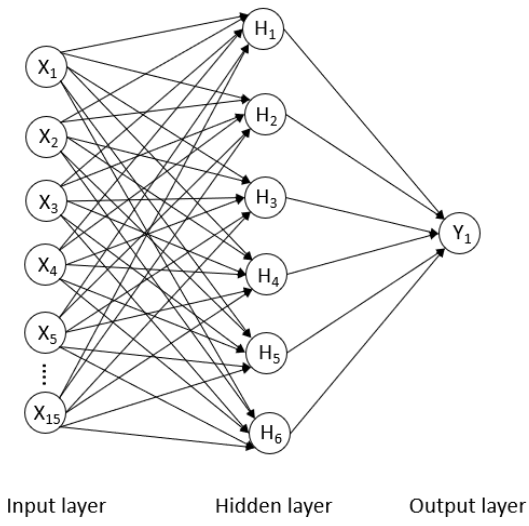
Figure 5. Diagram of the MultiLayer Perceptron (MLP).